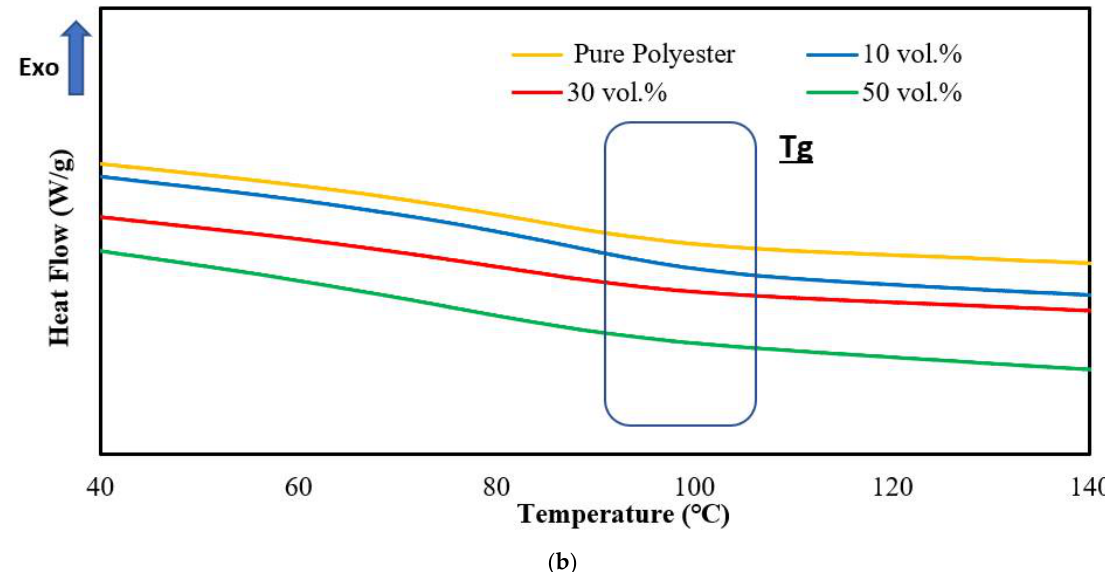
Figure 7. DSC thermal profile of UPR-PUD composites: ( a ) first and ( b ) second heating